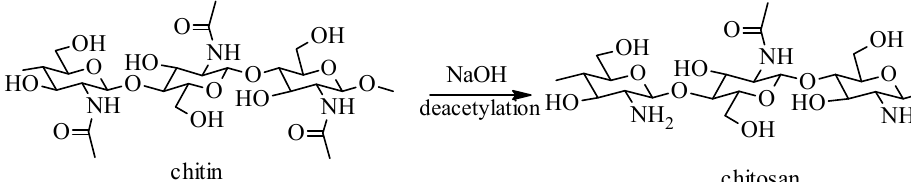
Figure 1. Scheme for chitosan production from chitin.